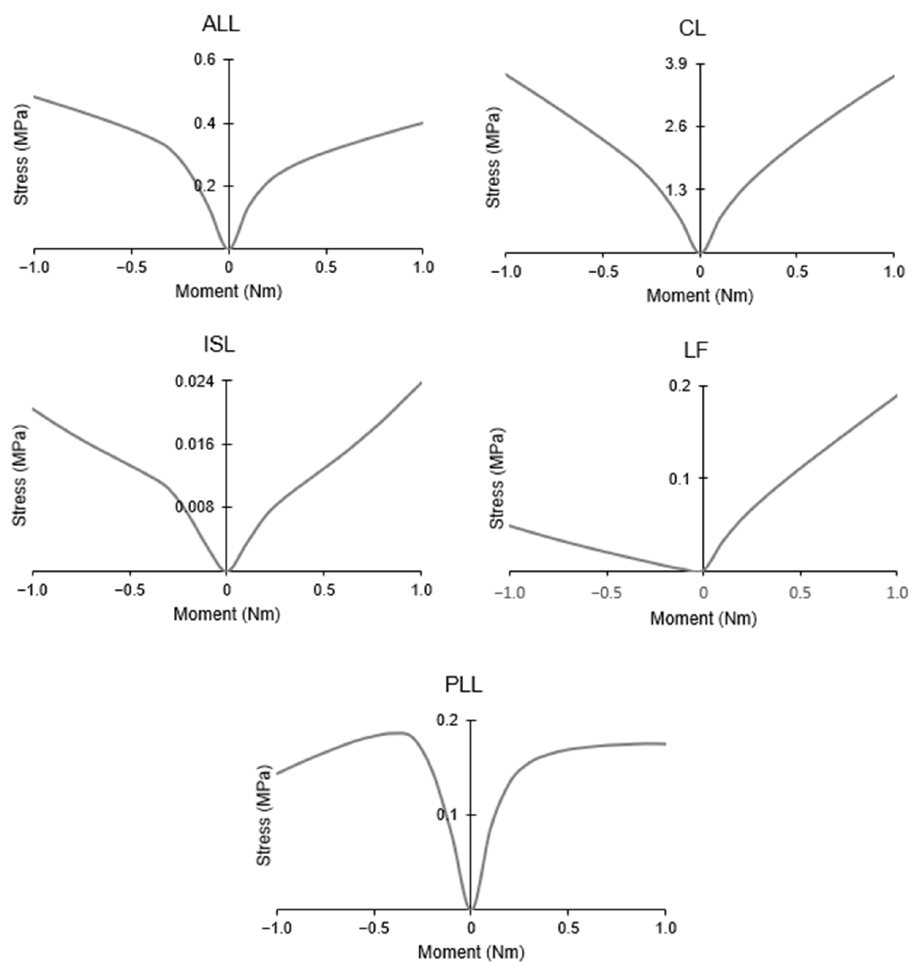
Figure 8. Maximum stress registered by each ligament during axial rotation.